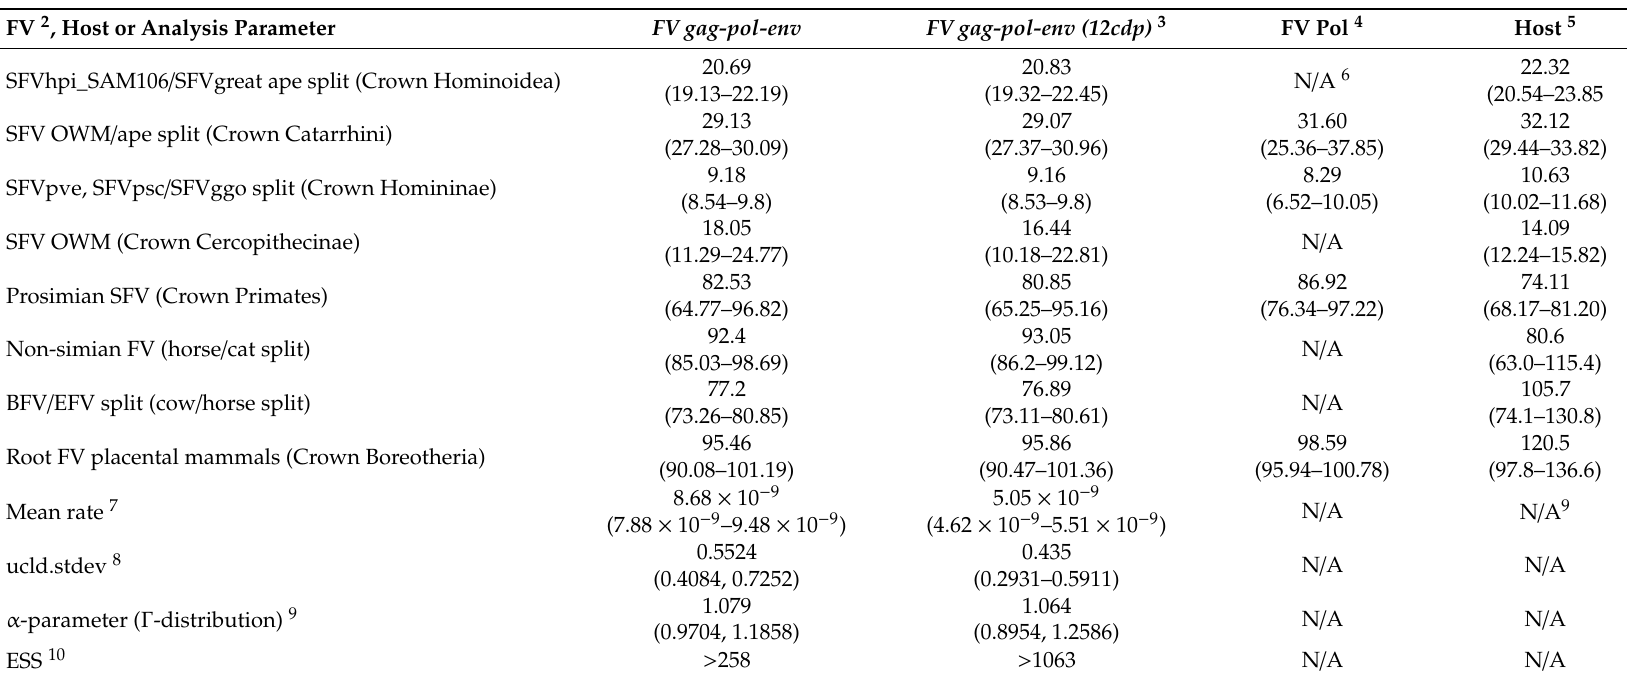
Table 4. Time to most recent common ancestor (TMRCA) estimates in millions of years ago and nucleotide substitution rates for foamy viruses (FVs) 1